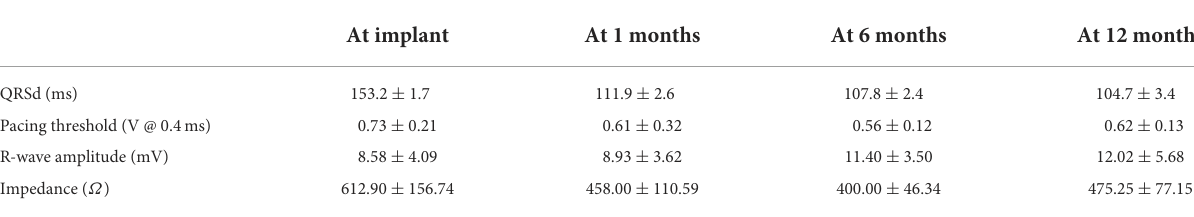
TABLE 2 Electrophysiological and pacing parameters. At implant At 1 months At 6 months At 12